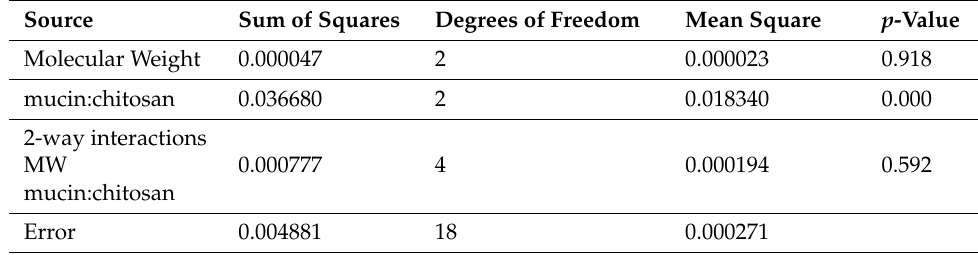
Table 4. Analysis of variance DoE I.